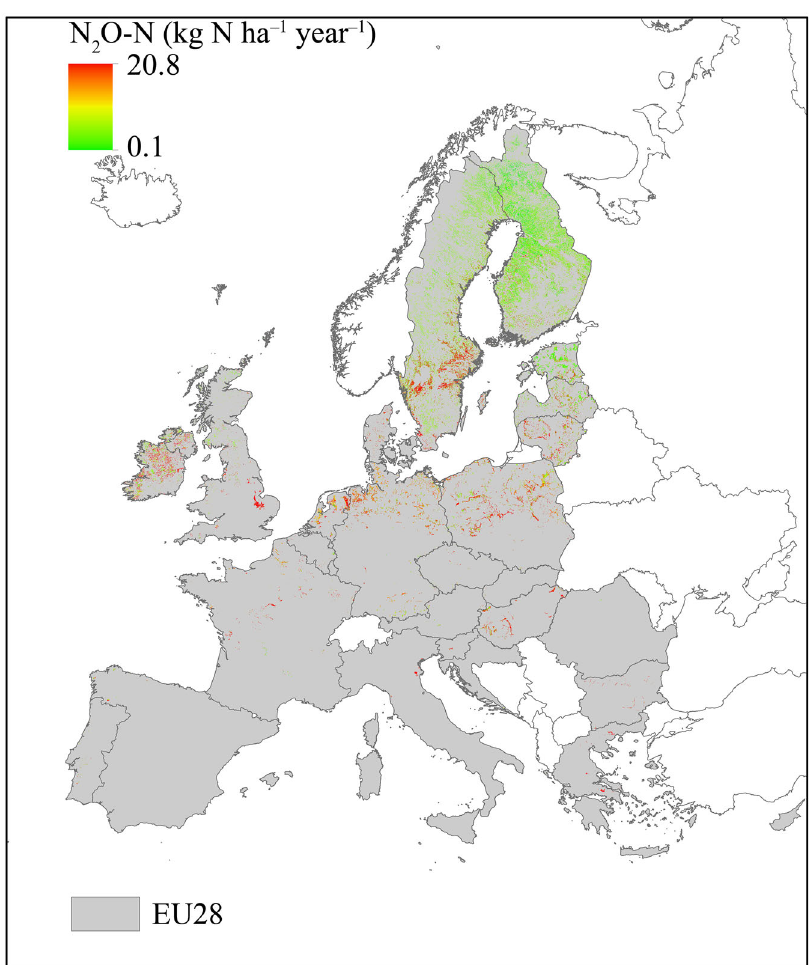
Fig. 1 Map of annual nitrous oxide (N 2 O-N) emissions from managed European peatlands. The grey regions refer to the European Union in 2013